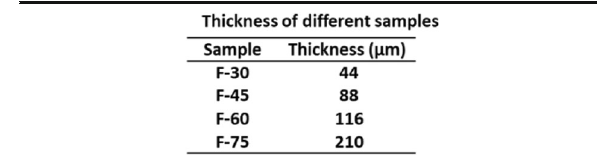
Table 1 Thickness of different samples